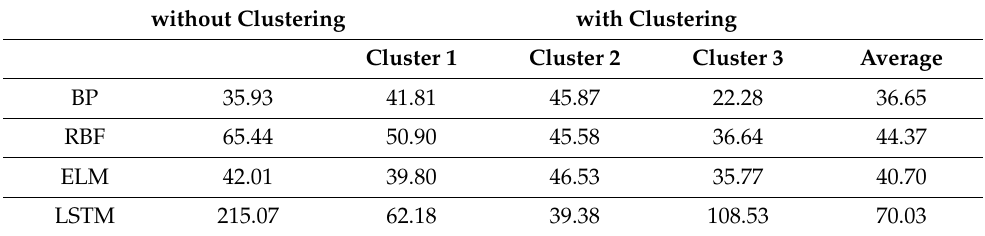
Table 2. MAE of solar radiation forecast errors in spring.